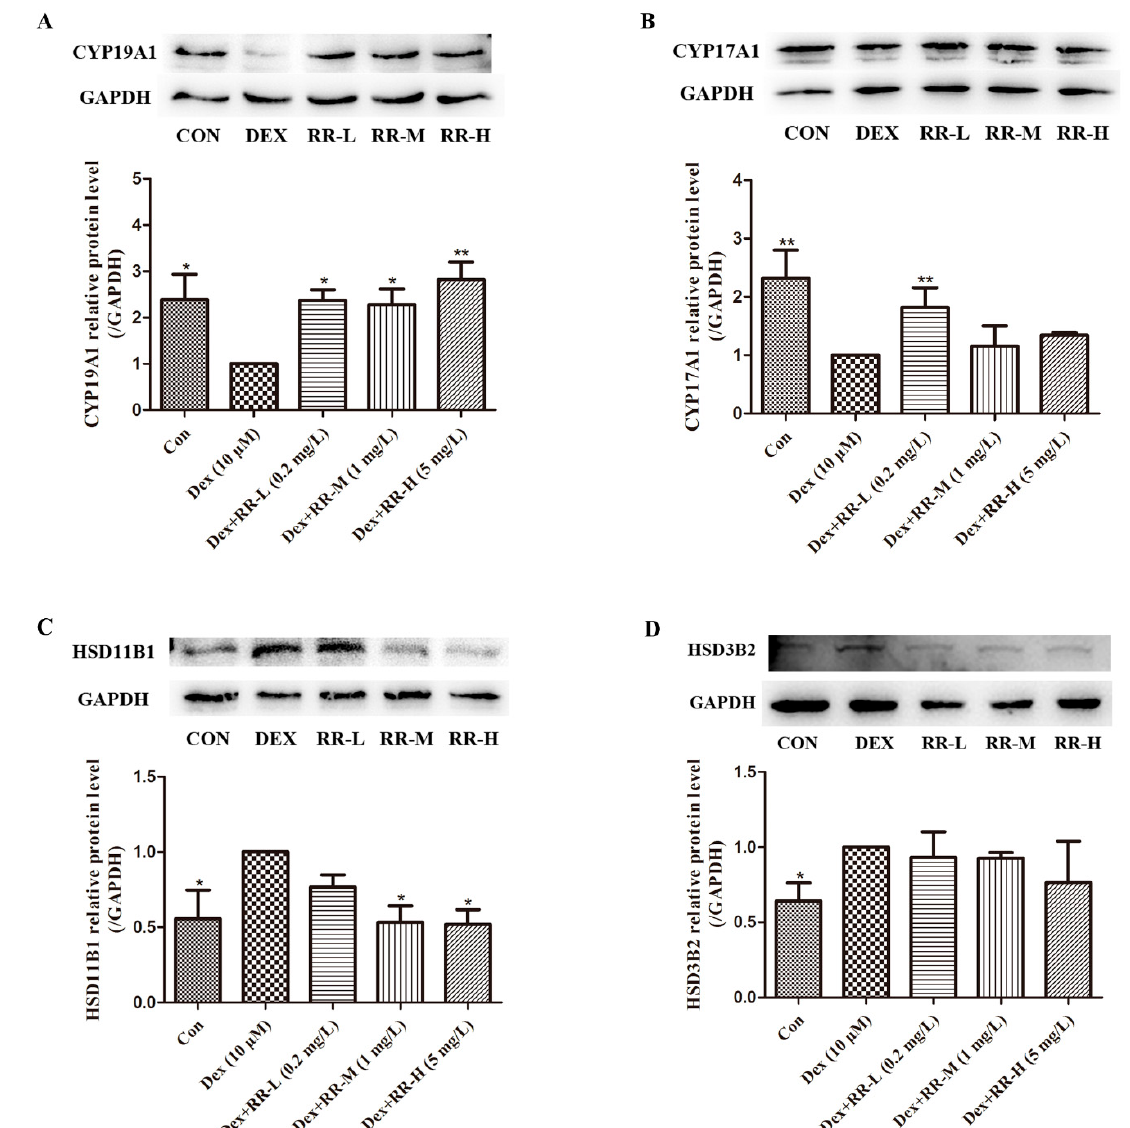
Figure 7. Effects of RR on the expression of key proteins related to steroid hormone biosynthesis. Protein expressions and relative levels of ( A ) CYP19A1; ( B ) CYP17A1; ( C ) HSD11B1; ( D ) HSD3B2 were analyzed by Western blotting. All values are expressed as the mean ± SD; n = 3. * p < 0.05, ** p < 0.01 compared with DEX